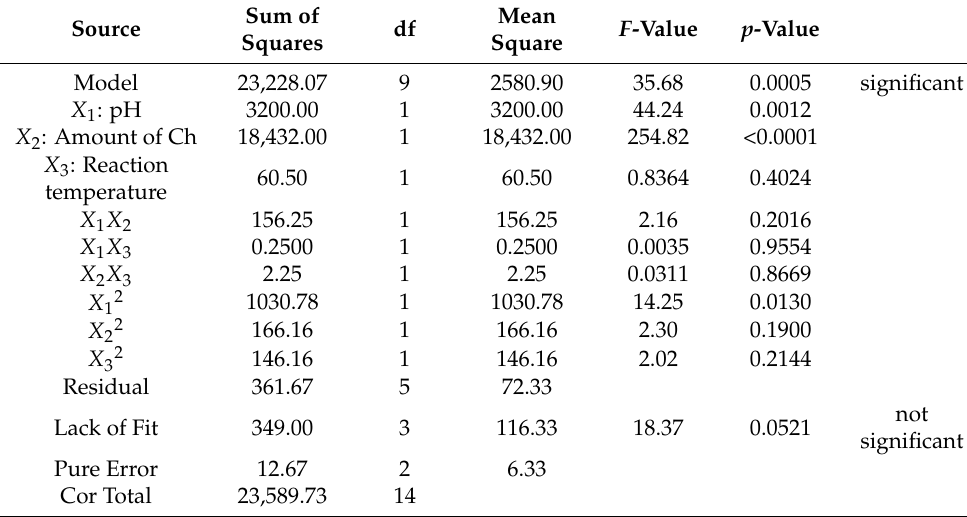
Table 3. ANOVA results for evaluating the RSM model for particle size.